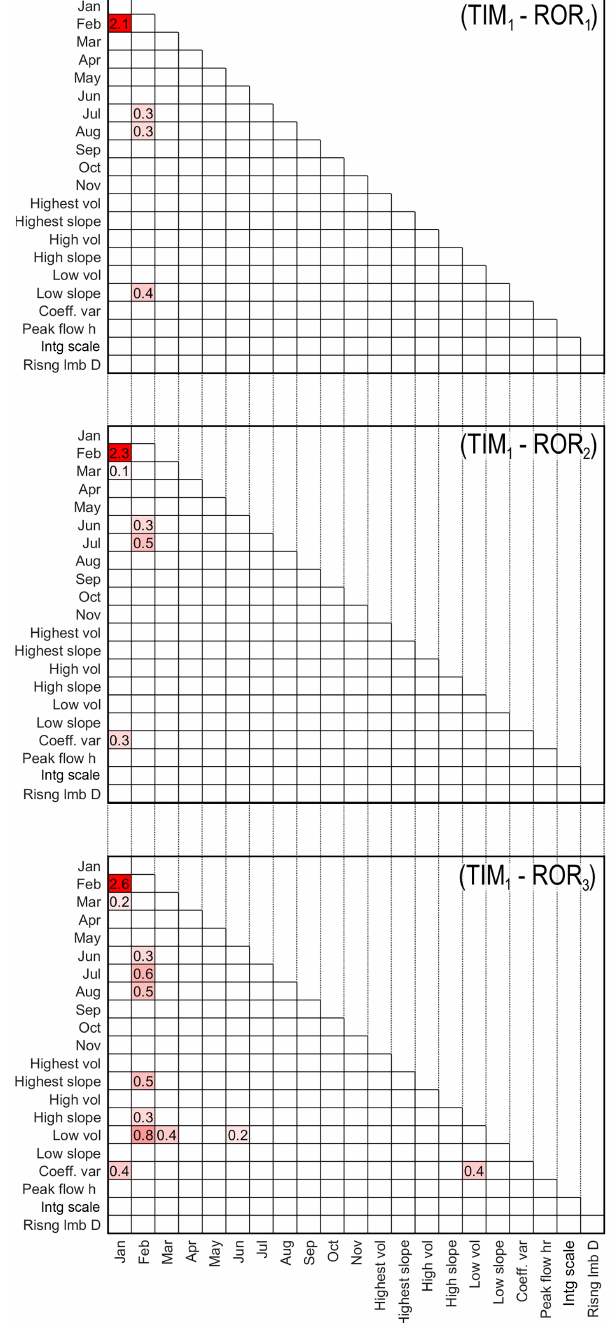
Figure 18. Average consistency scores between river discharge sig- natures using the three run-off-routing model structures in combi- nation with the TIM 1 melt model